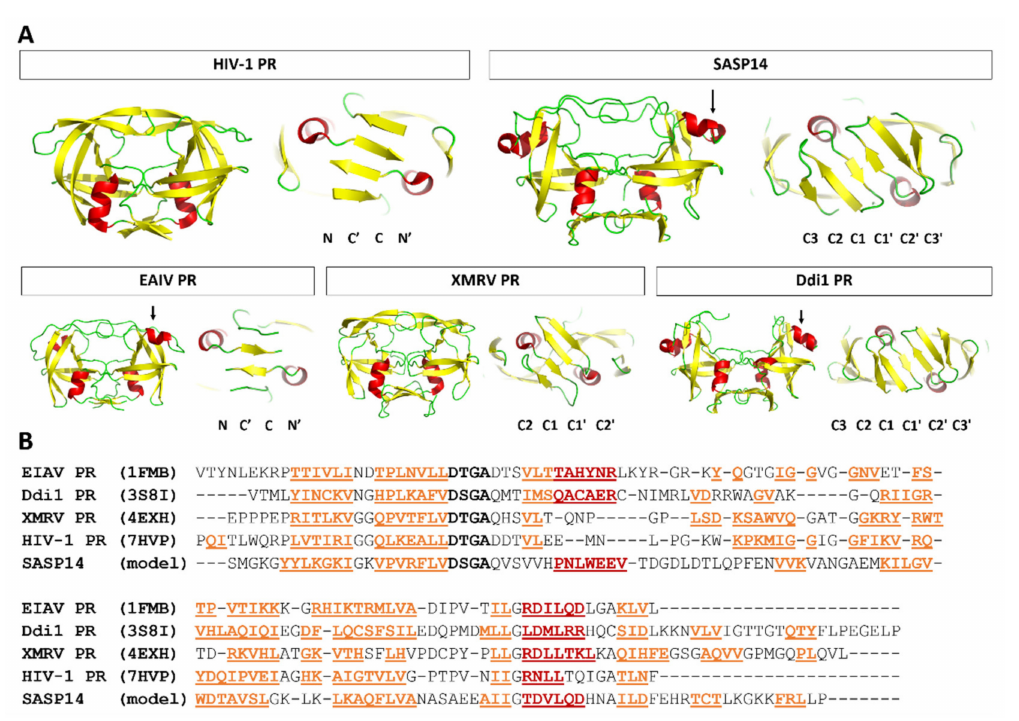
Figure2. OverallfoldofSASP14resemblestothoseofhomodimericasparticproteases. ( A )Structuresare presented based on the crystal structures of HIV-1 (PDBID: 7HVP), EIAV (PDBID: 1FMB), XMRV (PDBID: 4EXH), and human Ddi1 (PDBID: 3S8I) proteases, whereas homology model is shown for human SASP14 homodimer (1–124 residues). Front views of the proteases and enlarged dimer interfaces are shown, organizations of N- and C-terminal β -sheets in dimer interfaces are also indicated. Arrows indicate the additional helical inserts in EIAV, Ddi1, and SASP14 proteases. Color codes: yellow, β -strand; red, α -helix; green, loop. ( B ) Structure-based alignment of protease sequences. Secondary structural organizations are shown based on crystal structures, and based on prediction for SASP14. Color codes: yellow, β -strand; red, α -helix; active site motif residues, black and